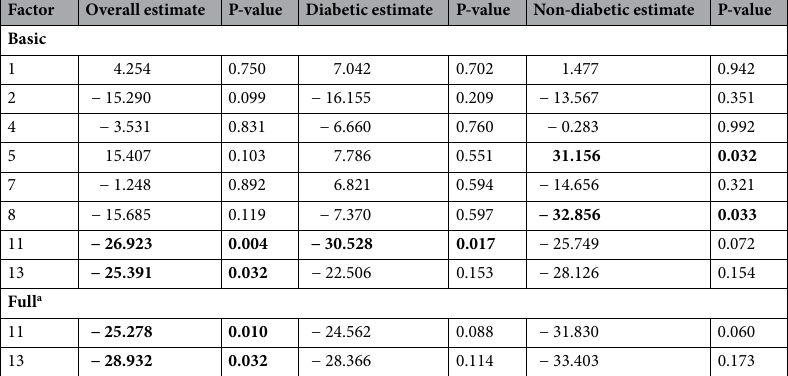
Table 5. Association of baseline factor level with 90-day change in 6-min walk distance (6MWD). Significant values are in bold. a Model: change in 6 min walk dist (D90 − baseline) ~ baseline factor + baseline 6 min